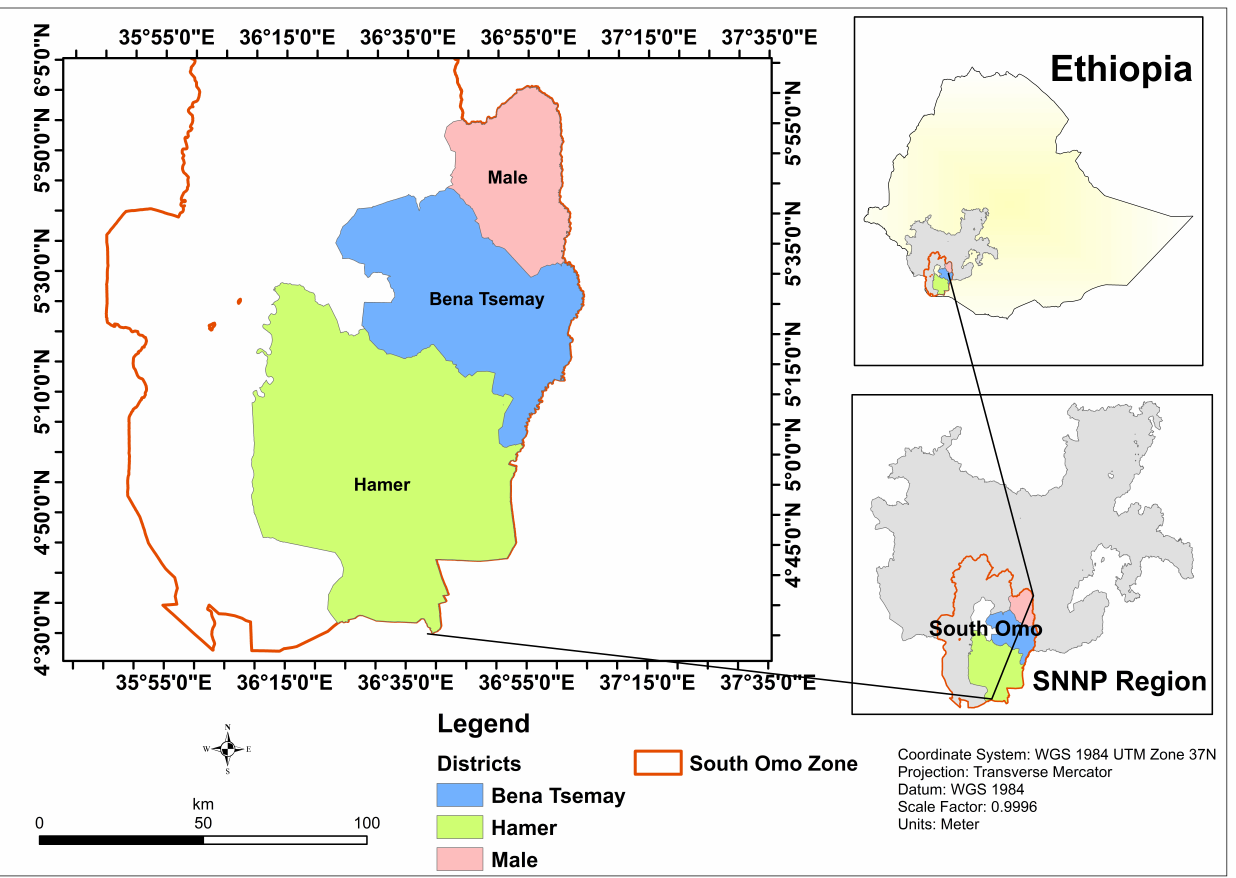
Figure 1. Map of the studied areas. The three study districts Bena Tsemay, Hamer and Male are located in South Omo, a zone within the Southern Nations Nationalities and Peoples Regional State (SNNP) in the southern part of Ethiopia.